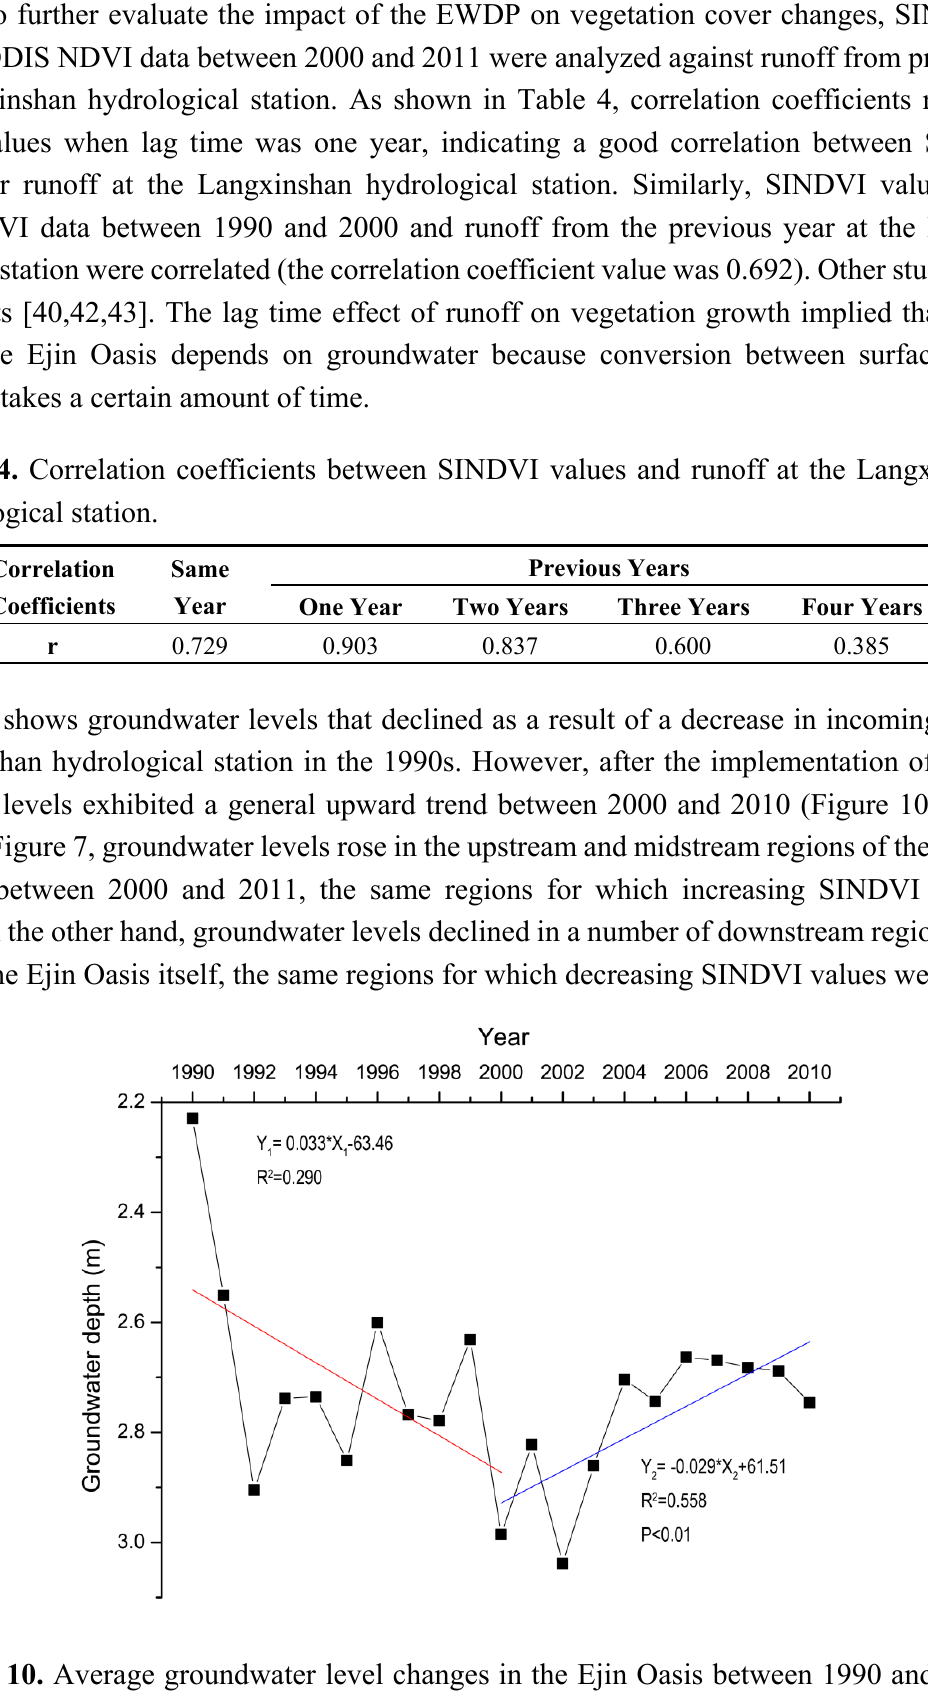
Figure 10. Average groundwater level changes in the Ejin Oasis between 1990 and 2010. The red and blue lines denote trends in groundwater level changes between 1990 and 2000 and between 2000 and 2010,